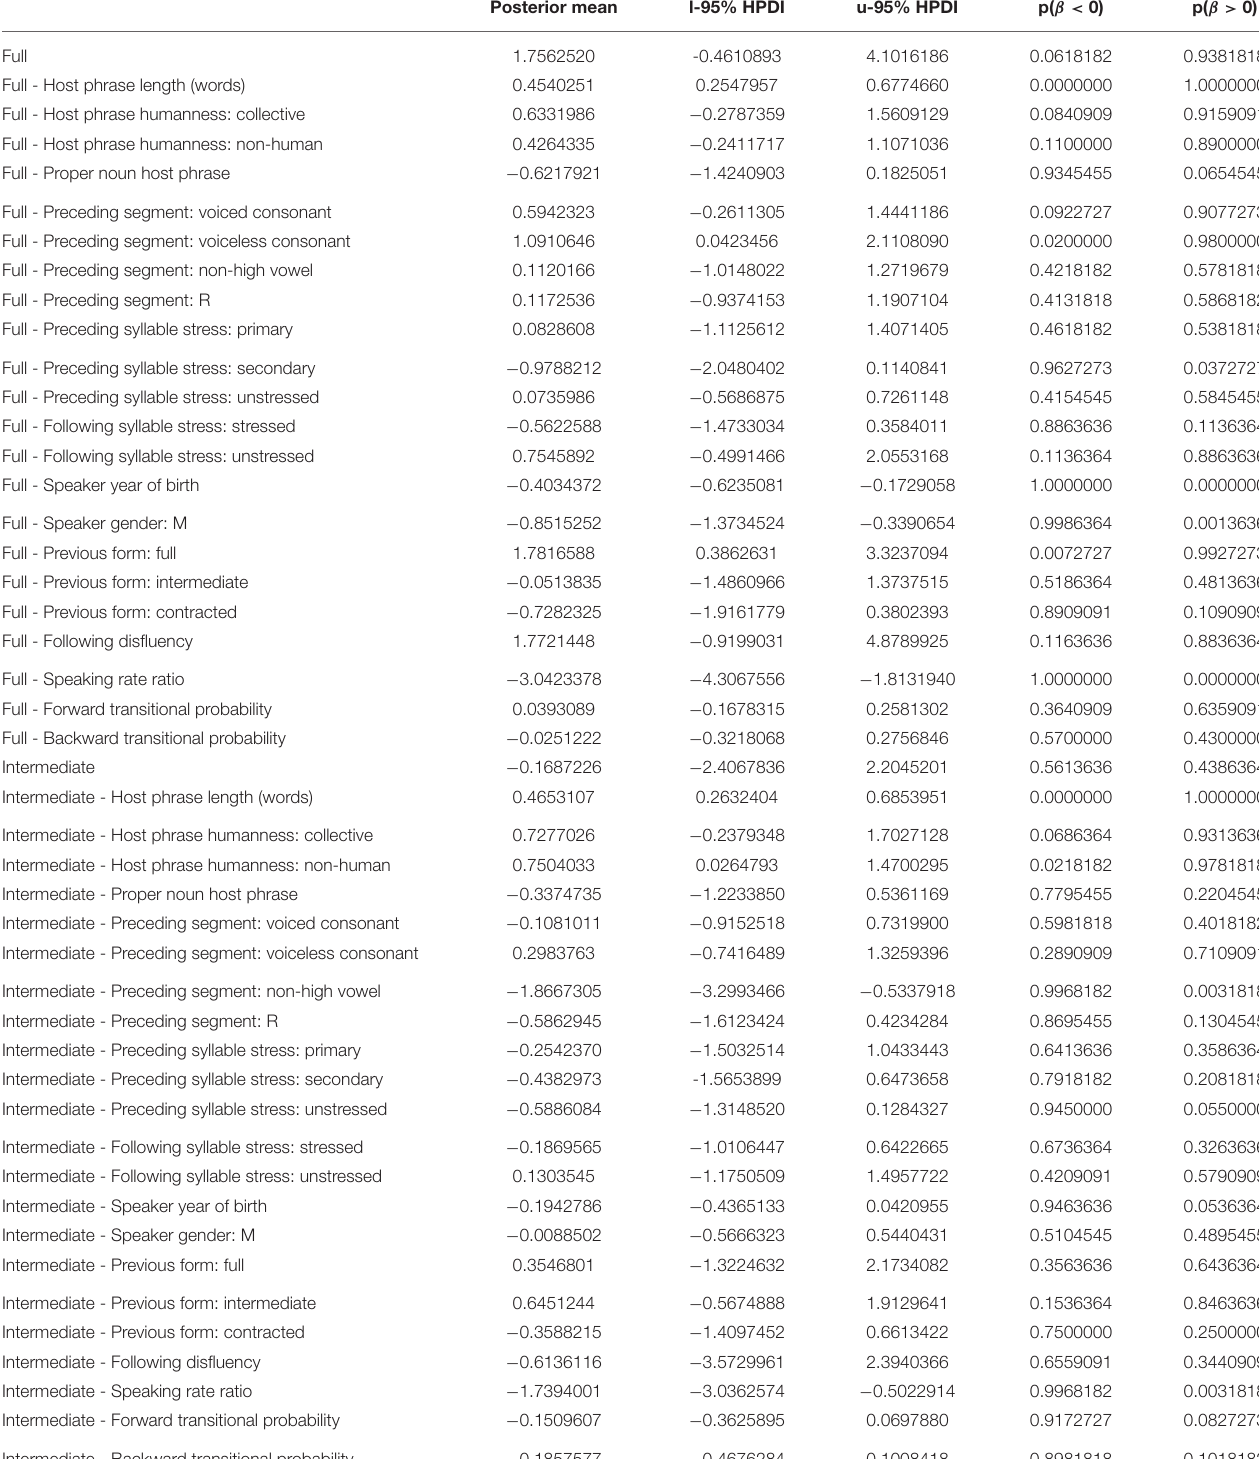
TABLE 5 | Model estimates for predictors influencing has